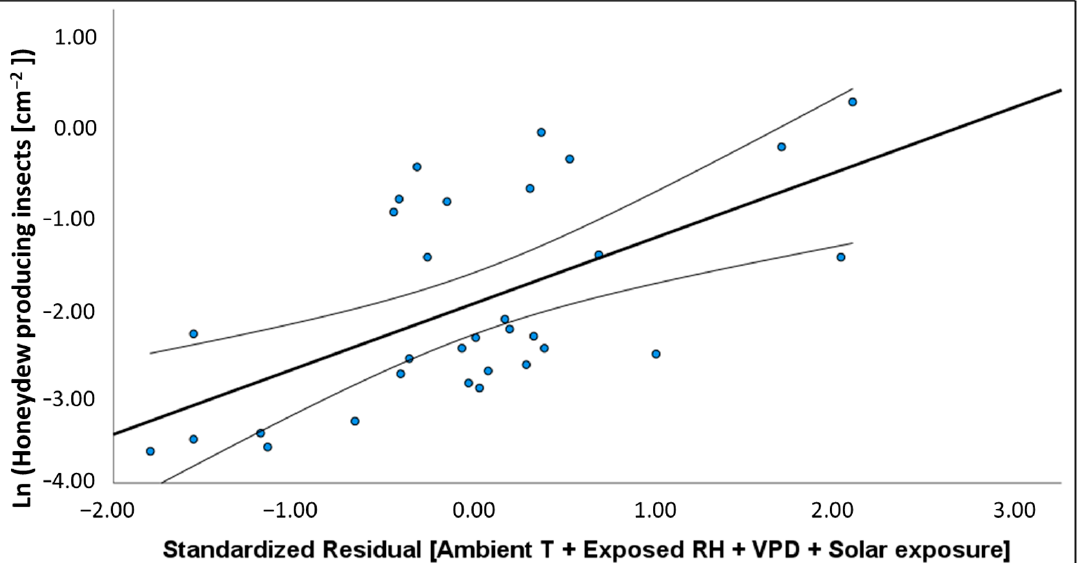
F 1,29 = 26.031, r 2 = 0.473; model equation: Y = 0.153 x + 0.3.